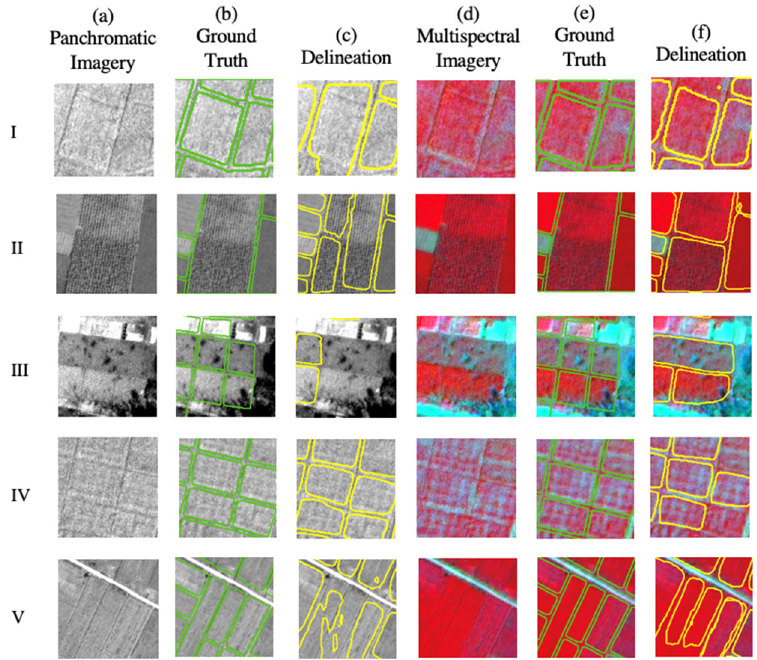
Figure 8. One example of a 512 × 512-pixels WV-3 unenhanced tile in Uttar Pradesh. Panel ( a ) shows the original panchromatic image, ( b ) shows the panchromatic image with ground truth, ( c ) shows the enhanced panchromatic image with delineated field boundaries, ( d ) shows the original multispectral image, ( e ) shows the multispectral image with ground truth, and ( f ) shows the enhanced multispectral image with delineated field boundaries. Results are shown for the final model, which included the iteratively collected data. Green lines represent ground truth field boundaries, and yellow lines represent predicted field boundaries.